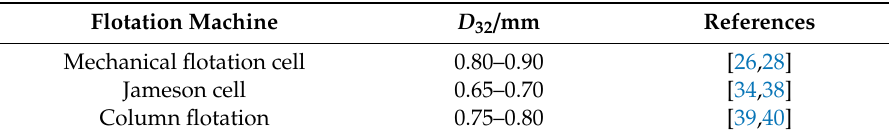
Figure 7. Effect of the frother concentration ( C ) on Sauter mean diameter ( D 32 ). Table 4. Comparison of D 32 in flotation machines at a critical coalescence concentration (CCC) of methyl isobutyl carbinol (MIBC).